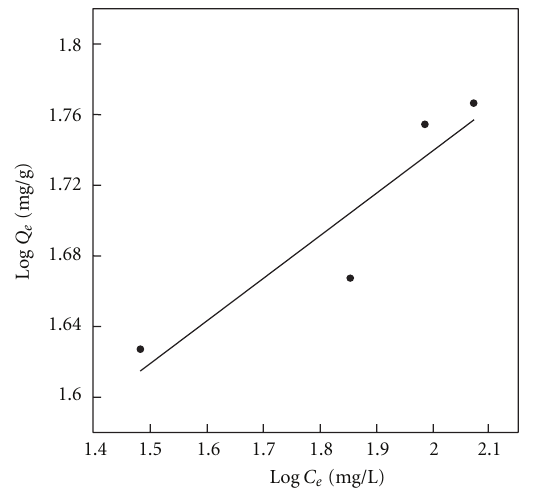
Figure 3: Freundlich isotherm plots of phenol adsorption onto BK (initial concentrations = 100–500 mg L − 1 , 25 ◦ C).